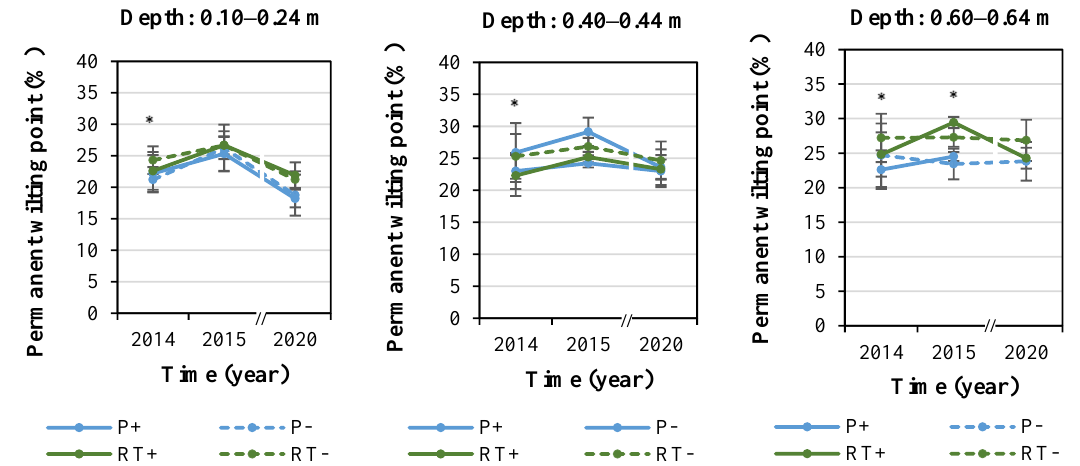
Figure 3. ( a ) total porosity, ( b ) air capacity, ( c ) field capacity, ( d ) plant-available water, ( e ) and permanent wilting point from 2014 to 2020. P: plow, RT: reduced tillage, +/ − : with and without compost ± standard deviation. Note: for 2020, the P+ value corresponding to the depth of 0.60–0.64 m is missing. * Significant effects between treatments with p < 0.05 (Tukey’s HSD, refer to the Text for details).